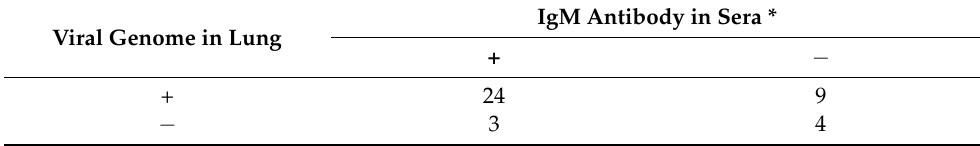
Figure 3. Relationship between virus genome copies in lung tissues and those in serum or feces of wild rats. Rats with viral genome loads exceeding 10 5 copies/mg in their lungs tended to have the genome in serum and feces. Male rats had more viral genomes in serum and feces than did female rats. Table 3. SEOV genome detection in lungs of IgG-positive wild rats.